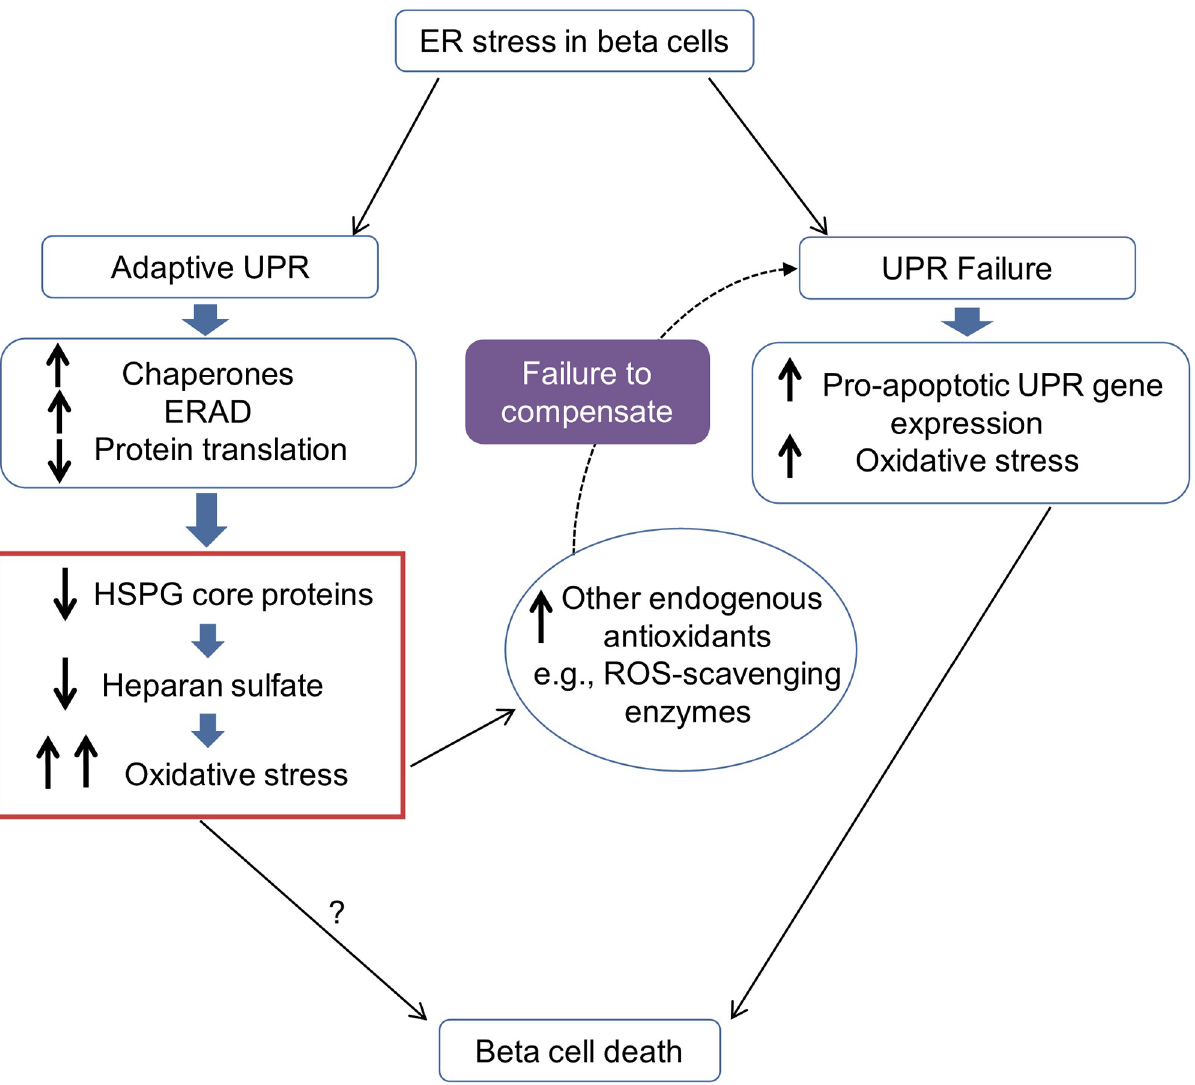
Fig 10. The proposed model: ER stress inhibits the synthesis of HSPG core proteins and HS in T2D-prone beta cells. In pre-T2D pancreatic beta cells, ER stress initiates the unfolded protein response (UPR) which acts to alleviate the stress by increasing molecular chaperones for protein folding, increasing ERAD and reducing the translation of mRNAs to a range of “general” proteins. As a consequence, HSPG core protein synthesis is impaired, which in turn severely reduces the synthesis of HS, a constitutive non-enzymatic antioxidant in beta cells. Depletion of beta cell HS increases intracellular ROS and elevates oxidative stress. Oxidative stress induces the expression of secondary antioxidant enzymes to help maintain beta cell homeostasis [57]. Failure to compensate for this stress results in UPR failure, the preferential expression of apoptotic genes and beta cell apoptosis/ death. ERAD, ER-associated degradation; T2D, Type 2 diabetes; HS, heparan sulfate; HSPG, heparan sulfate proteoglycan; ROS, reactive oxygen species.